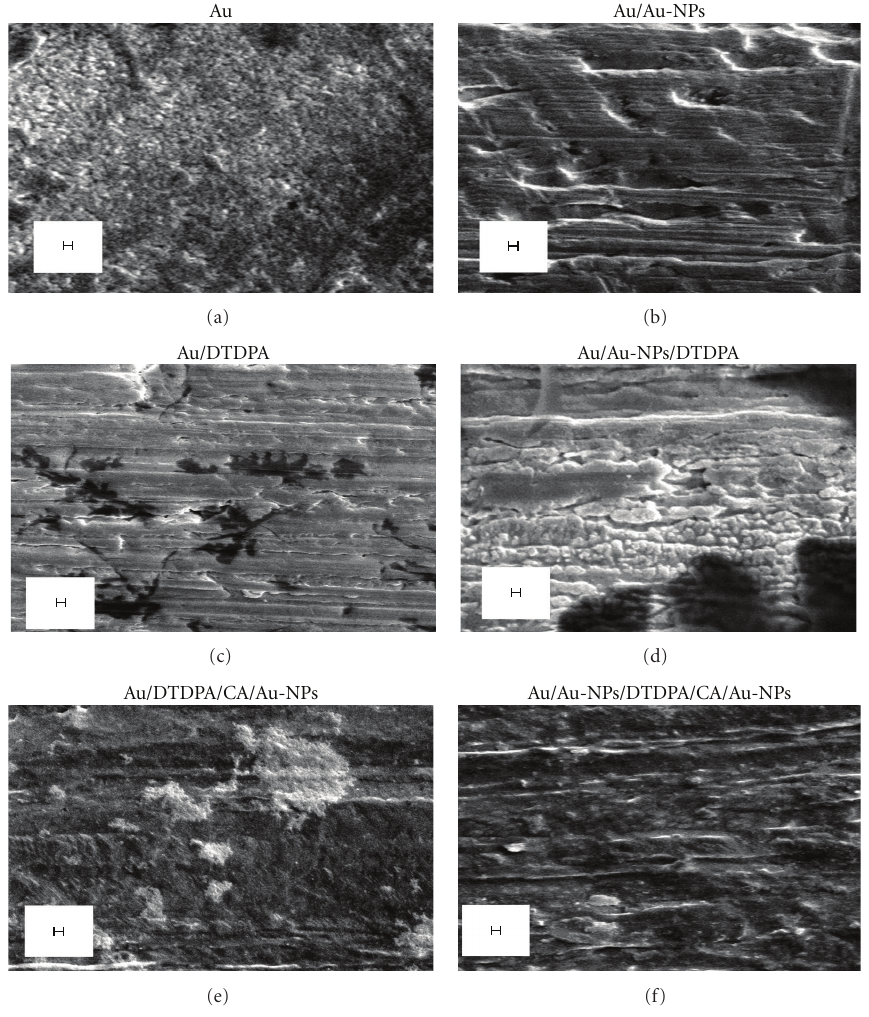
Figure 3: Scanning electron micrographs of the bare Au surface and surfaces modified by deposition of Au-NPs, CA, and DTDPA. Magnification: 10000x; accelerating voltage: 20 kV. Scale bar: 2 µ